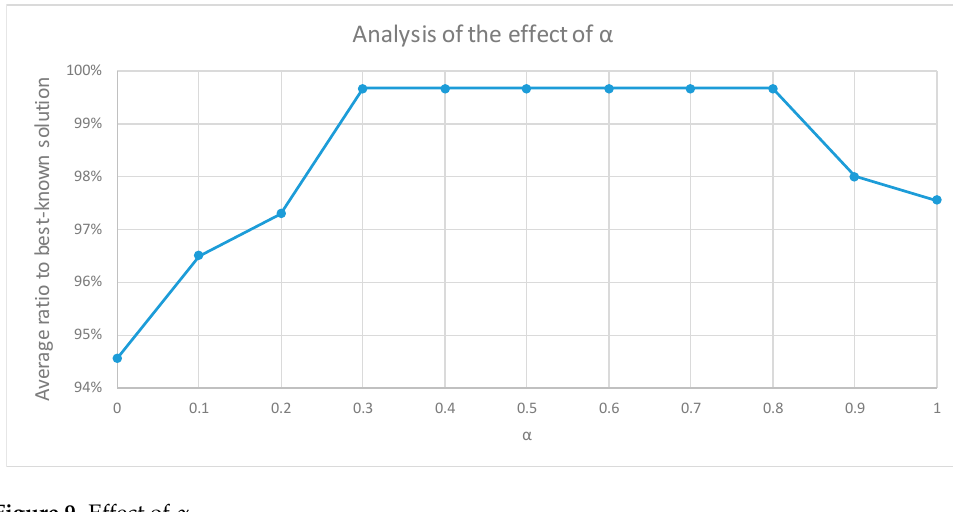
Figure 9. Effect of α .